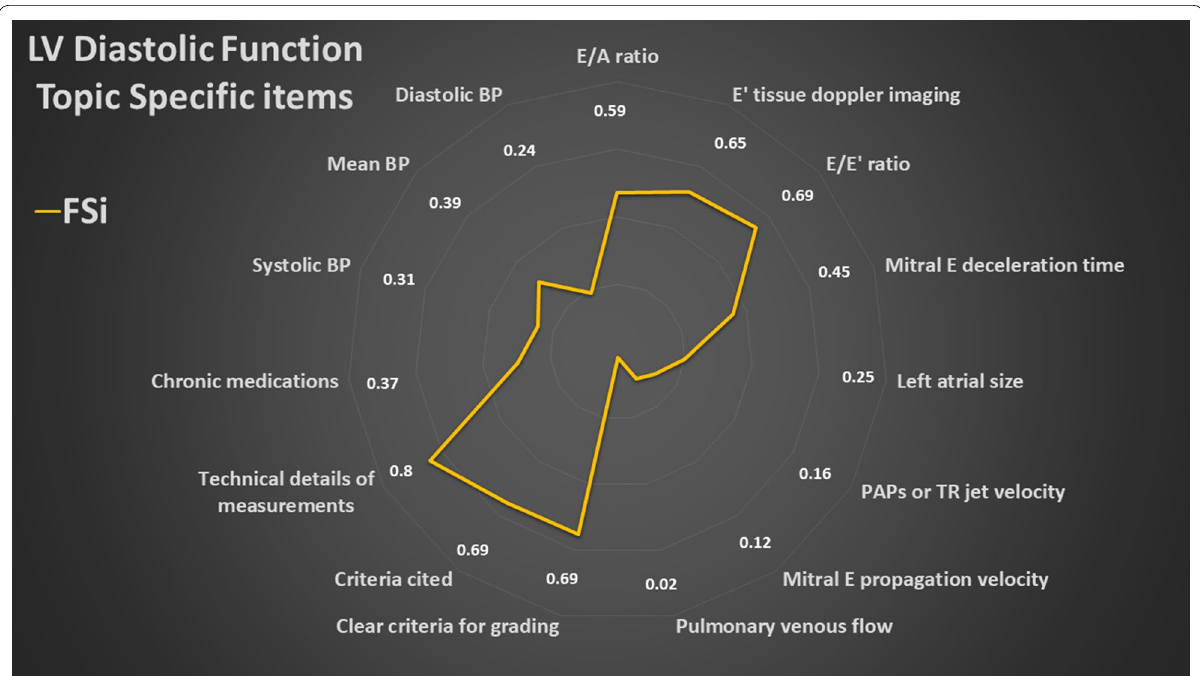
Fig. 5 Radar plot of the fraction of studies reporting an item (FSi) in the left ventricular (LV) diastolic function topic. A atrial wave of transmitral diastolic blood flow, BP blood pressure, E early wave of transmitral diastolic blood flow, E ʹ maximal diastolic early velocity by tissue Doppler imaging at the mitral annulus, PAPs pulmonary artery systolic pressure, TR tricuspid regurgitation. As example, an FSi score of 0.59 for E / A ratio means that 59% of studies on LV diastolic function reported E / A